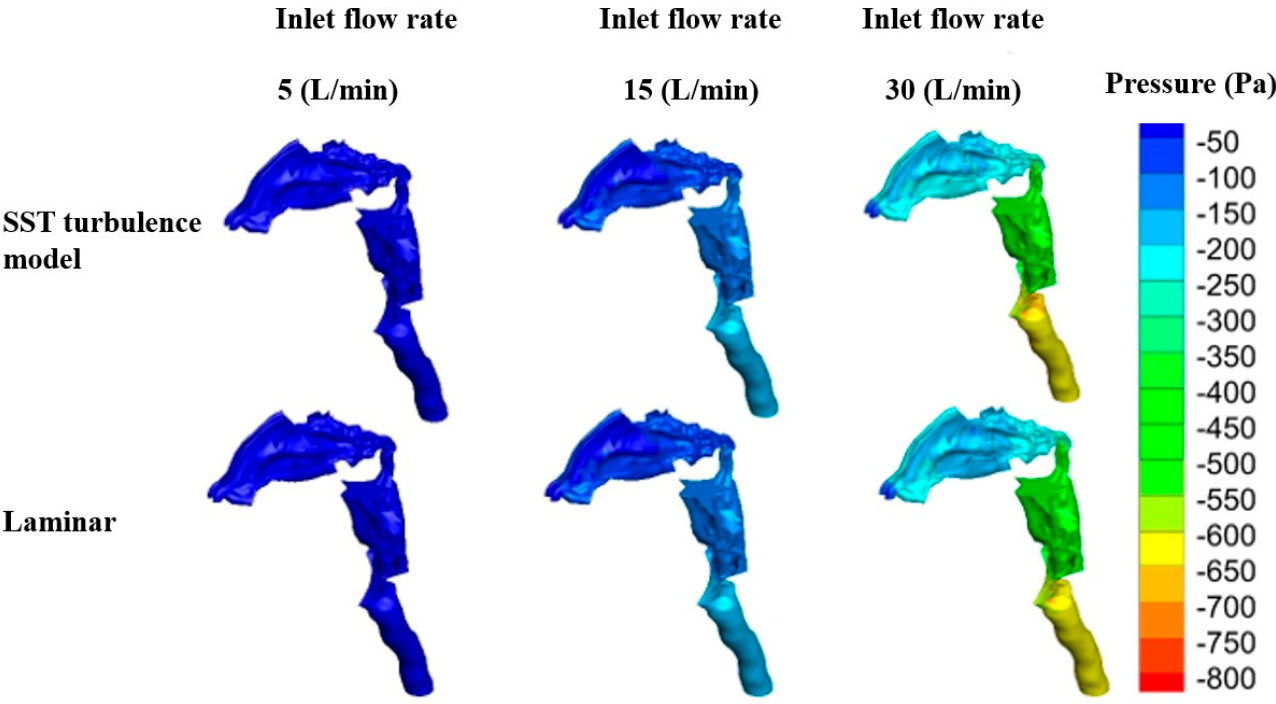
Figure 7. Pressure distribution at various inhalation rates for SST transient and laminar viscous model. The difference between laminar and SST transient viscous models is not